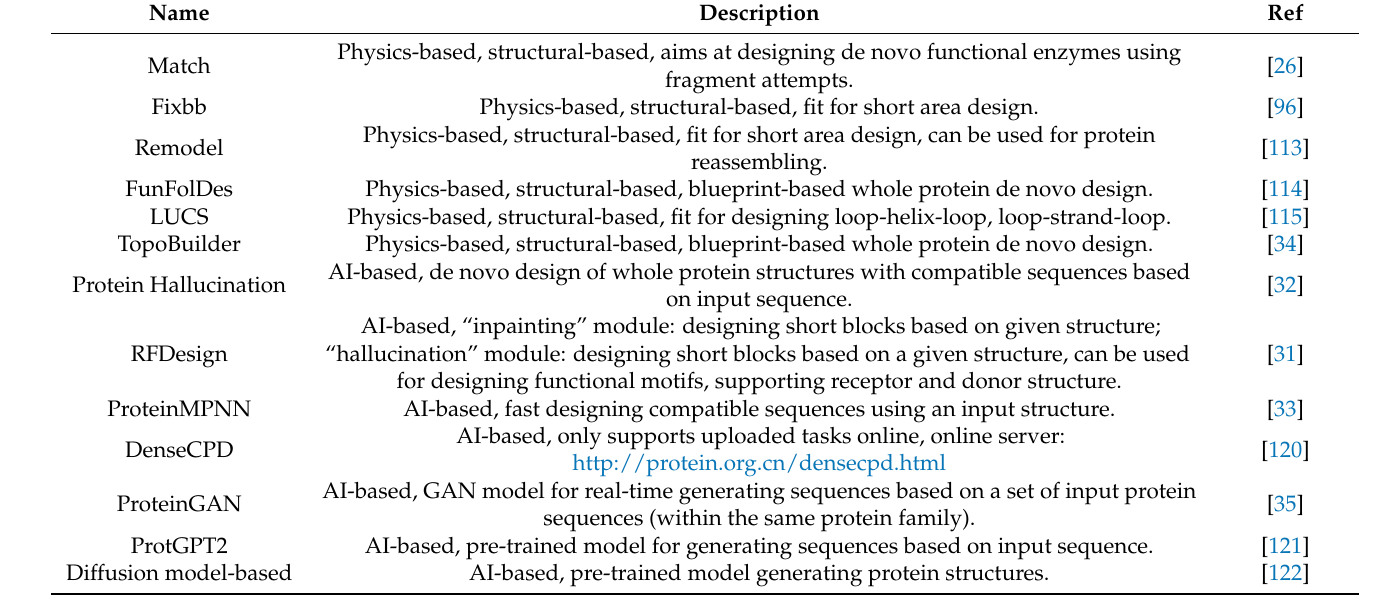
Table 4. De novo design